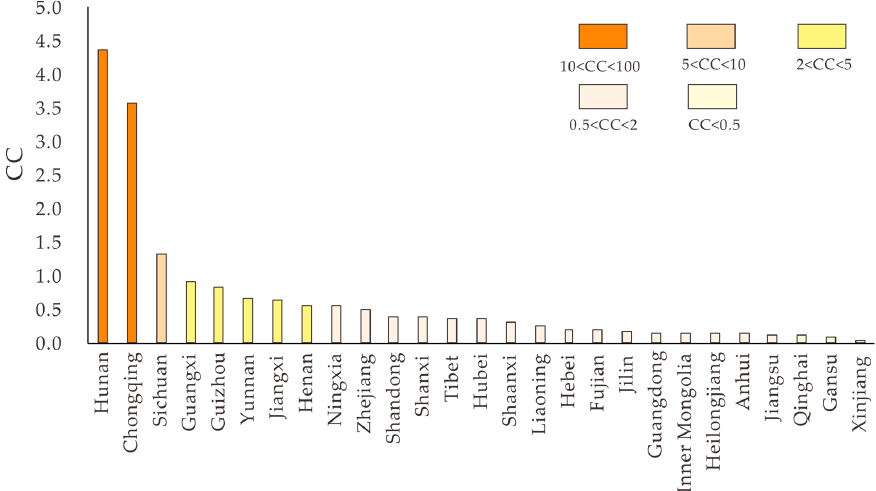
Figure 1. Arithmetic mean values of cadmium in coals from different provinces of China (CC: concentration coefficient, cadmium value from Dai et al. (0.25 μ g/g) [7] was used to determine CCs; there were no data in Taiwan, Hainan, Beijing, Tianjin, and Shanghai).